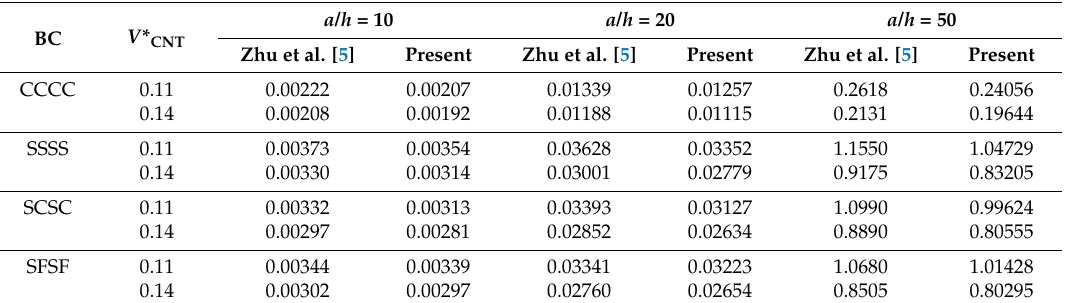
Table 8. Comparison study of non-dimensional maximum deflection of various volume fraction of UD CNT-reinforced composite plate.